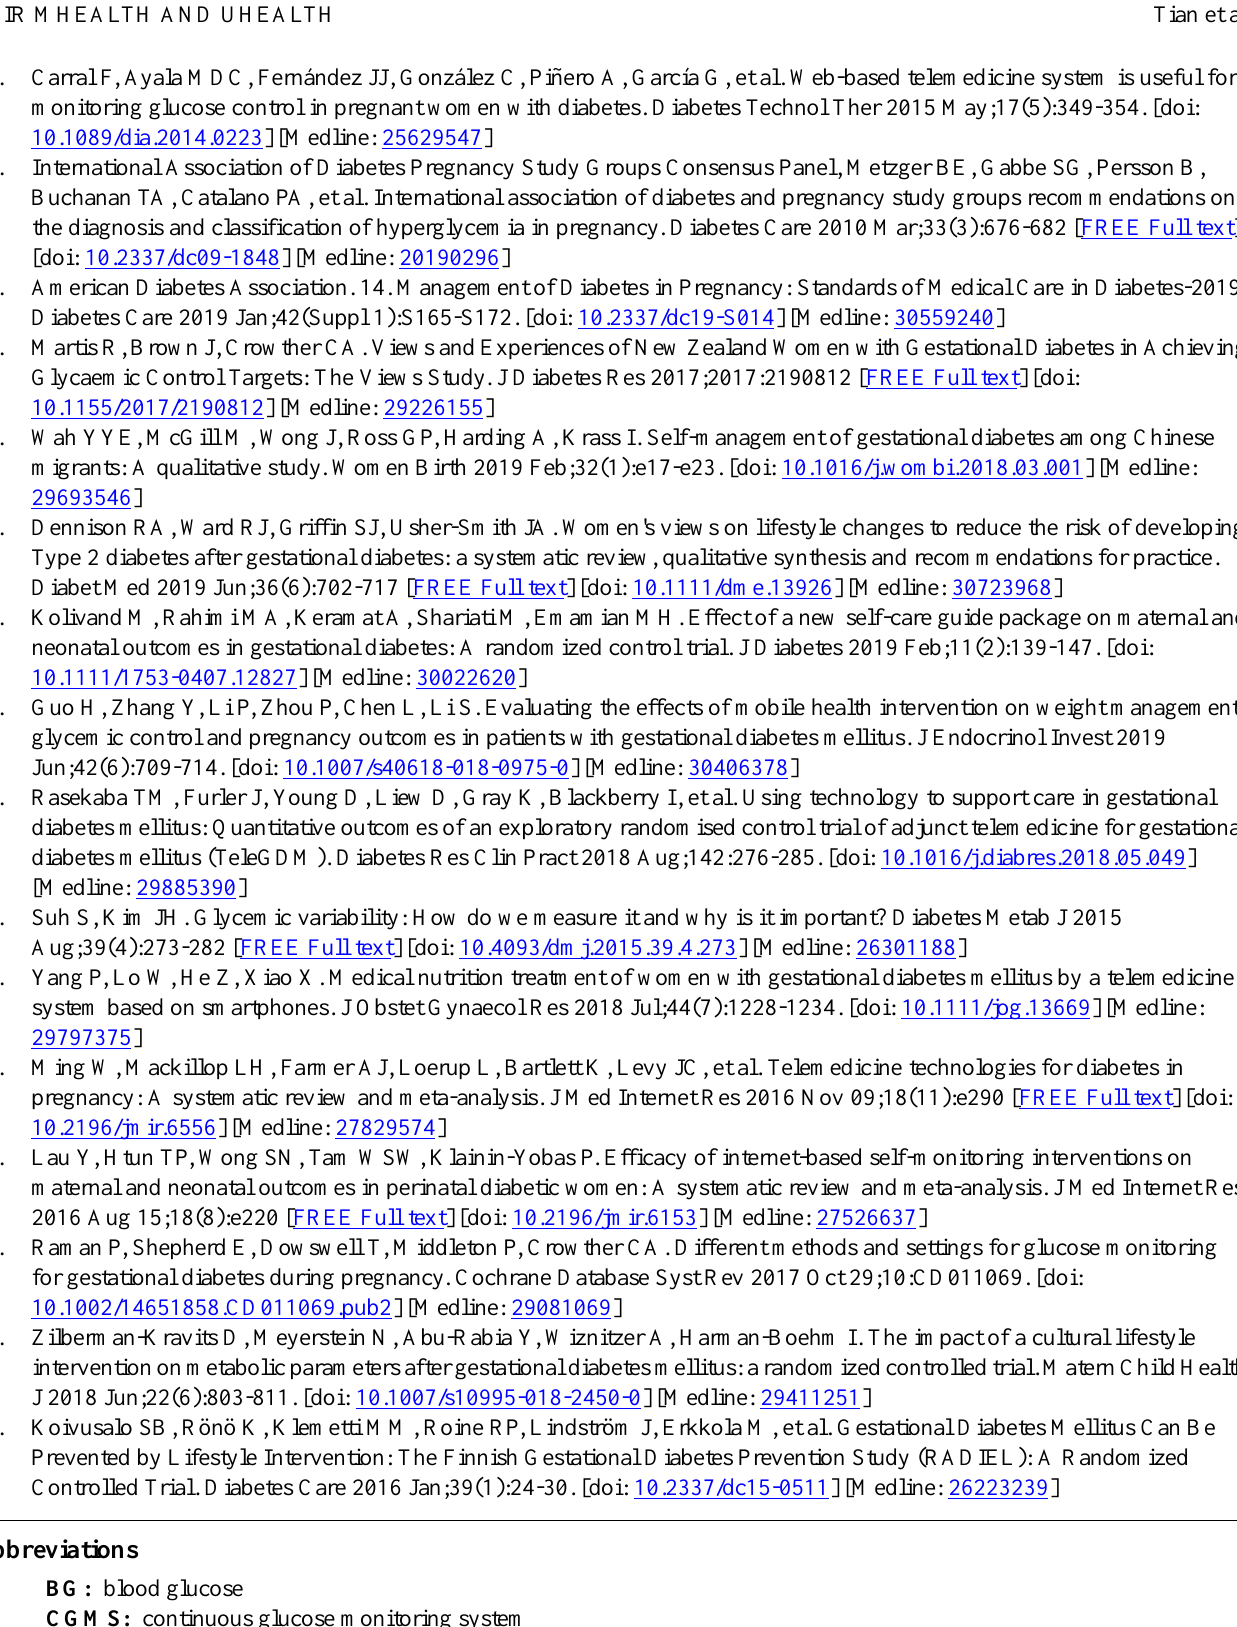
CGMS: continuous glucose monitoring